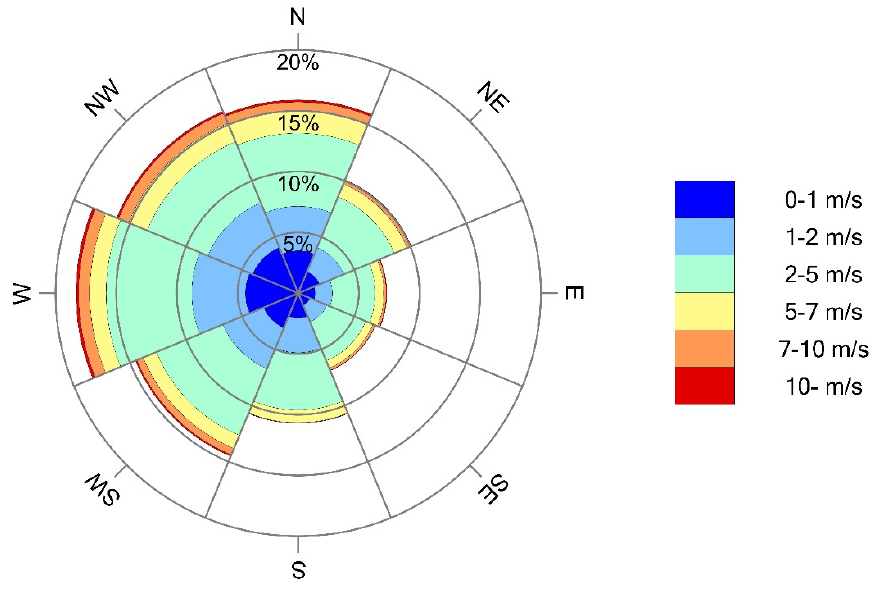
Figure 4. Wind velocity frequency (%) sorted by incidence angle.